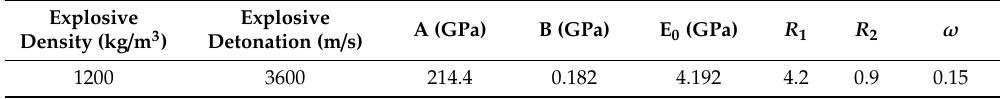
Table 3. Parameters of the explosives and JWL equation.